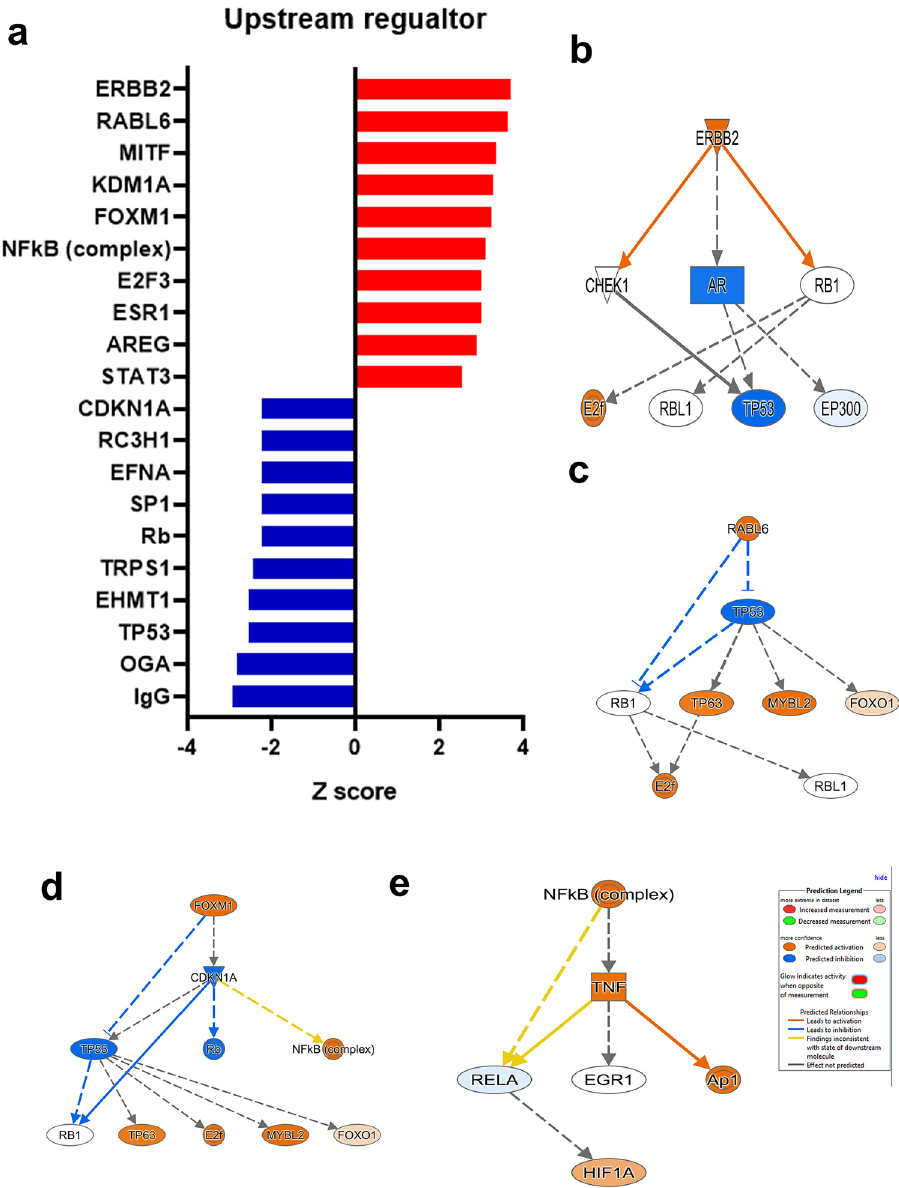
represent the activation Z score. ( b–e) are representation of ERBB2, RABL6, FOXM1, and NFKB networks, Fig. 2c. Figure 2e highlights the downstream effects of NFkB activation, which activates TNF, which in turn activates Ap1 but suppresses RELA (inconsistent). This inhibition of RELA is predicted to activate HIF1A as an indirect effect of NFkb activation.